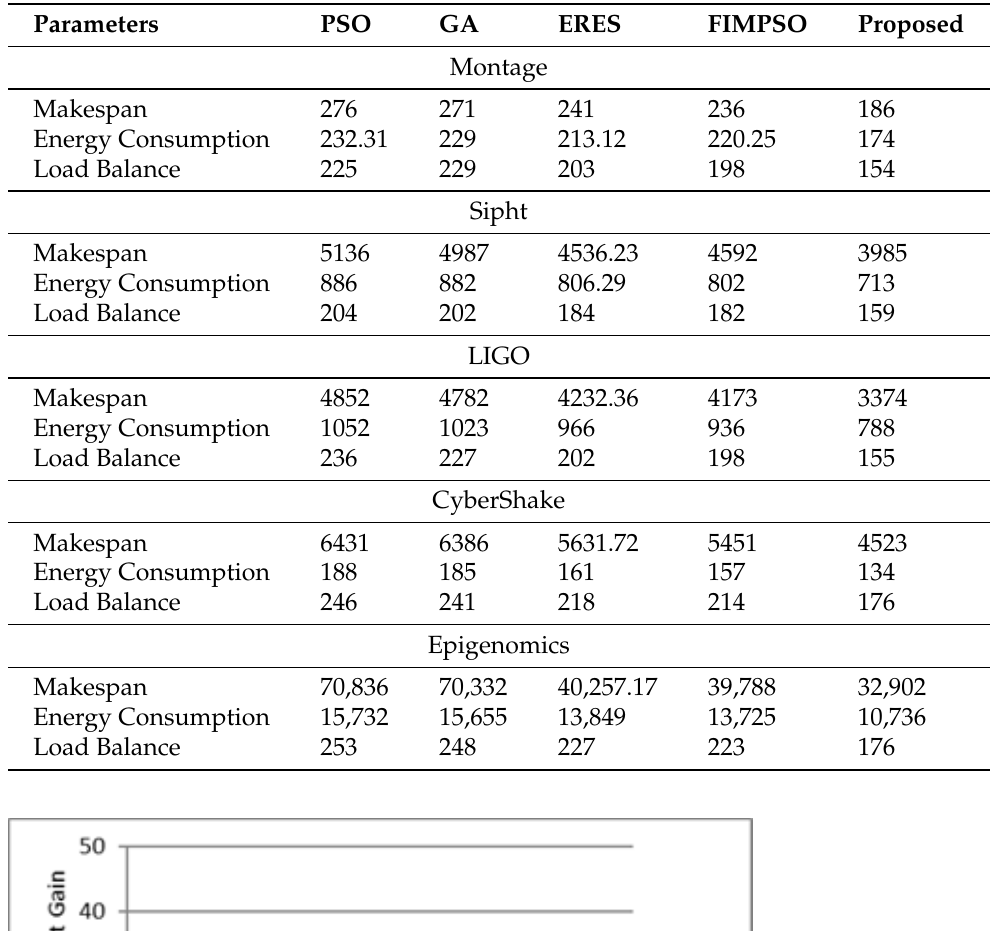
Table 2. Results of the proposed algorithm compared with those of standard and specialized schedulers on different workflows. Energy consumption is represented in KWh.